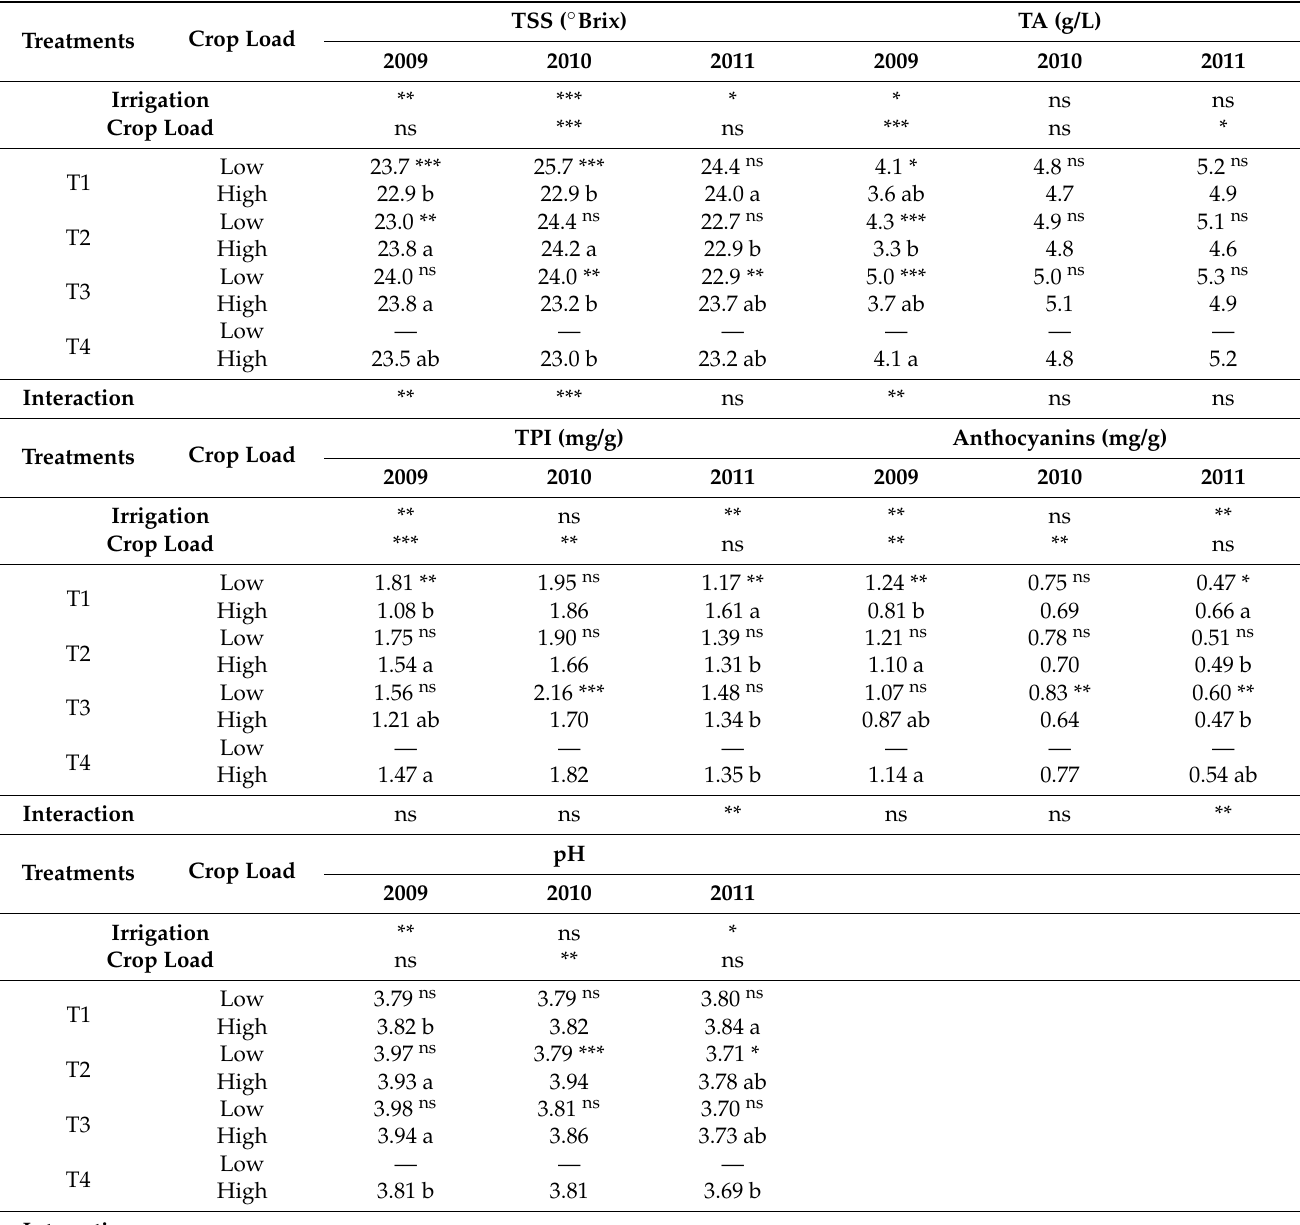
Table 6. Must characteristics, total soluble solids (TSS), titratable acidity (TA), total polyphenol index (TPI), and anthocyanins determined on fresh weight and pH in the years 2009, 2010, and